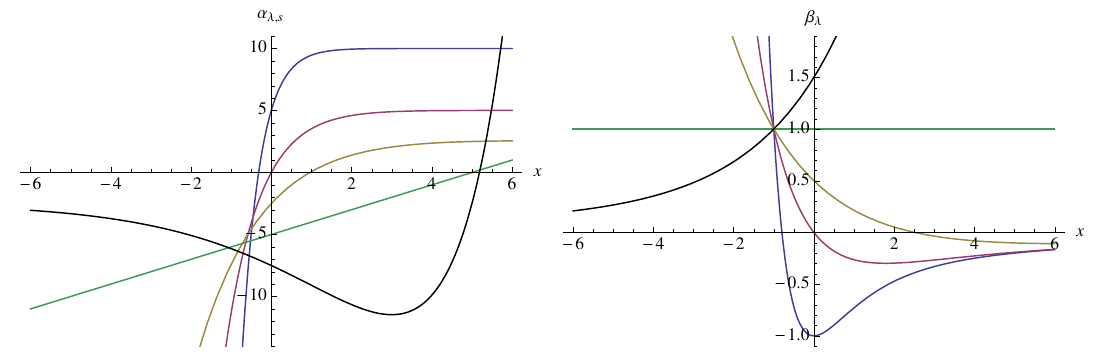
Figure 2 . Pro(cid:12)le of (cid:11) (cid:21);s ( x ) and (cid:12) (cid:21) ( x ) for (cid:21) = 2 : 0 (blue), (cid:21) = 1 : 0 (red), (cid:21) = 0 : 5 (yellow), (cid:21) = 0 (green) (cid:21) = (cid:0) 0 : 5 (black). Here we set s = 5. Transverse